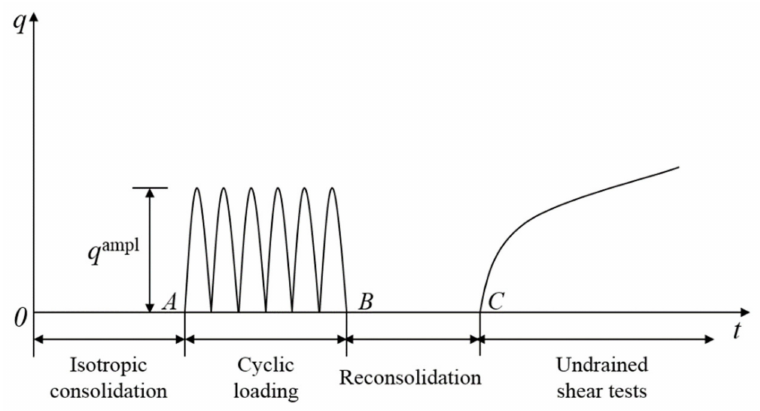
Figure 3. Loading process applied to the